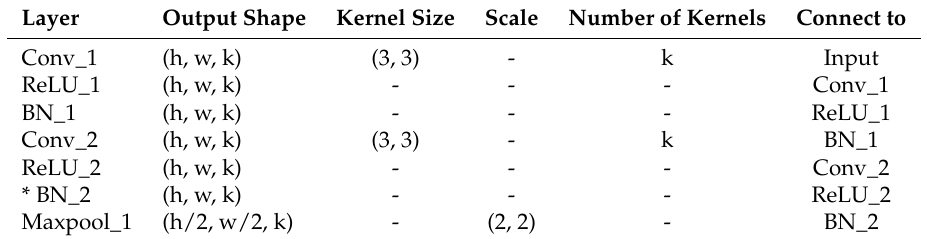
Table 1. Configuration of conv & pool block.